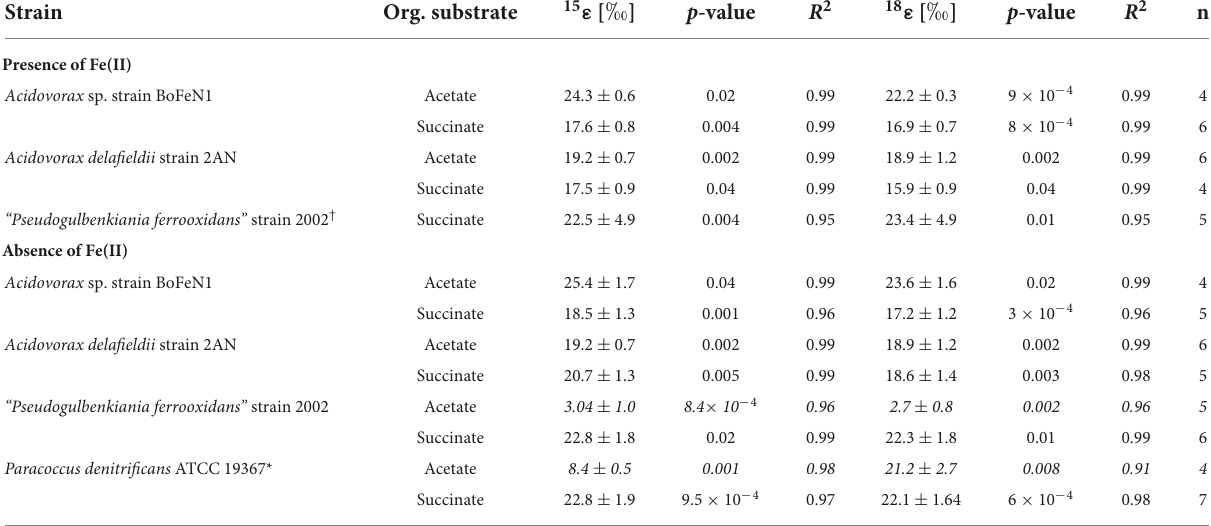
TABLE 2 Fractionation factors and p -values calculated for the different strains grown on NO 3 − and either acetate or succinate, and in the presence/absence of Fe(II) ± standard error.